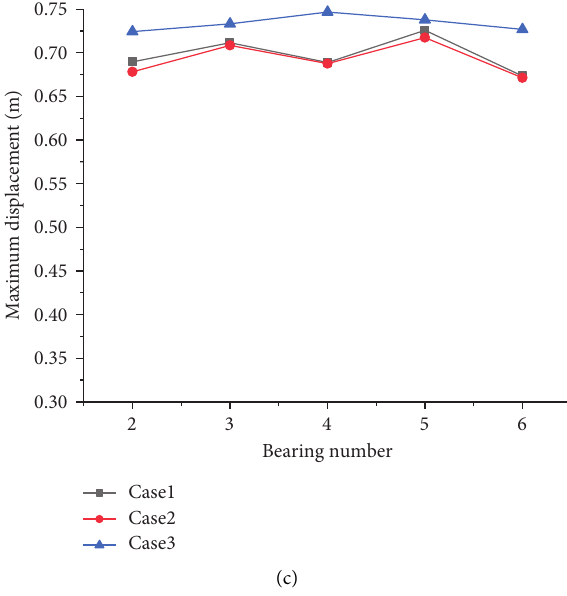
Figure 14: Longitudinal peak displacement of bearings in the three earthquakes. (a) 2011-03-11. (b) 2012-03-14. (c)